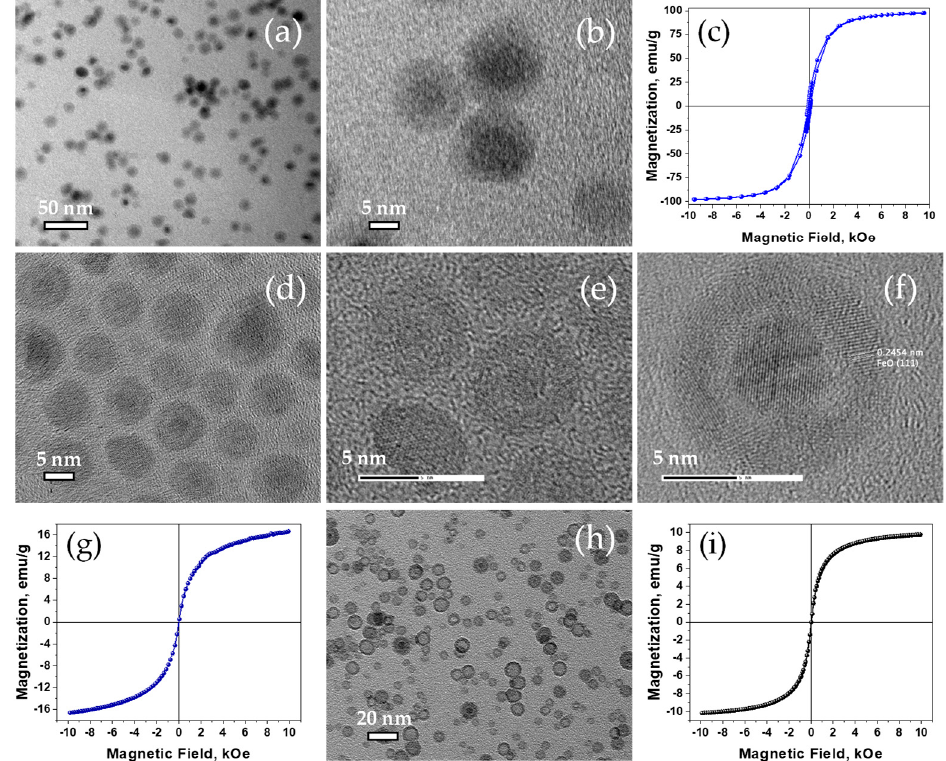
Figure 4. TEM images of the ~12 nm water soluble TMAOH functionalized Fe/Fe-oxide core/shell nanoparticles ( a , b ), and their room temperature magnetic hysteresis loop ( c ). TEM images of ~7 nm Fe/Fe-oxide synthesized with injection at 240 °C next day ( d – f ) and the corresponding room temperature magnetic hysteresis loop ( g ). TEM image of the hollow nanoparticles arising from the complete oxidation of the corresponded core/shell ones ( h ) and their room temperature magnetic hysteresis loop ( i ).